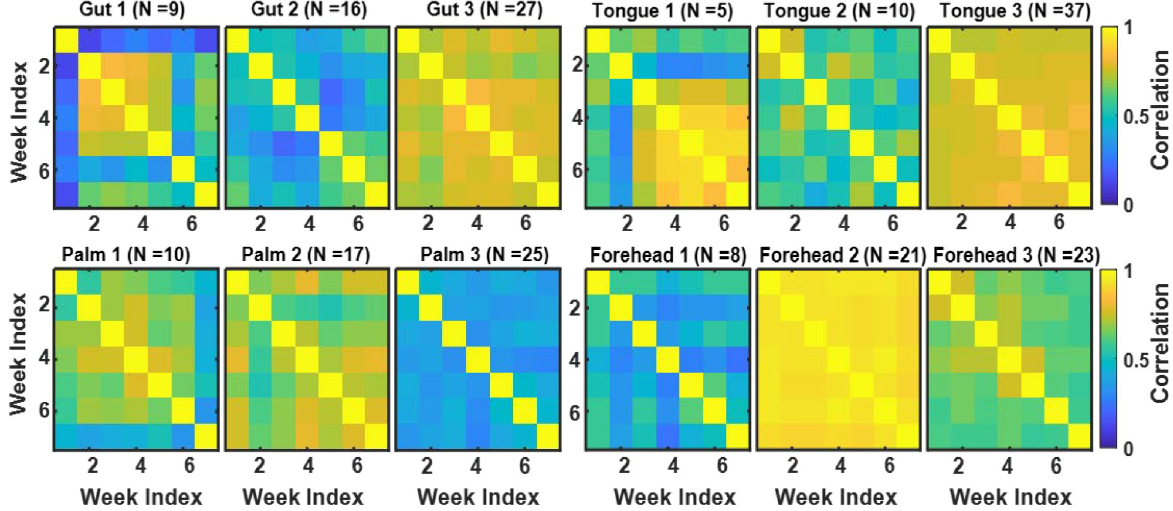
Fig 11. Correlation matrices reflecting microbiome dynamics at four body sites (gut, tongue, palm, and forehead) for three clusters of students identified based on the microbiome data for each of the body sites.